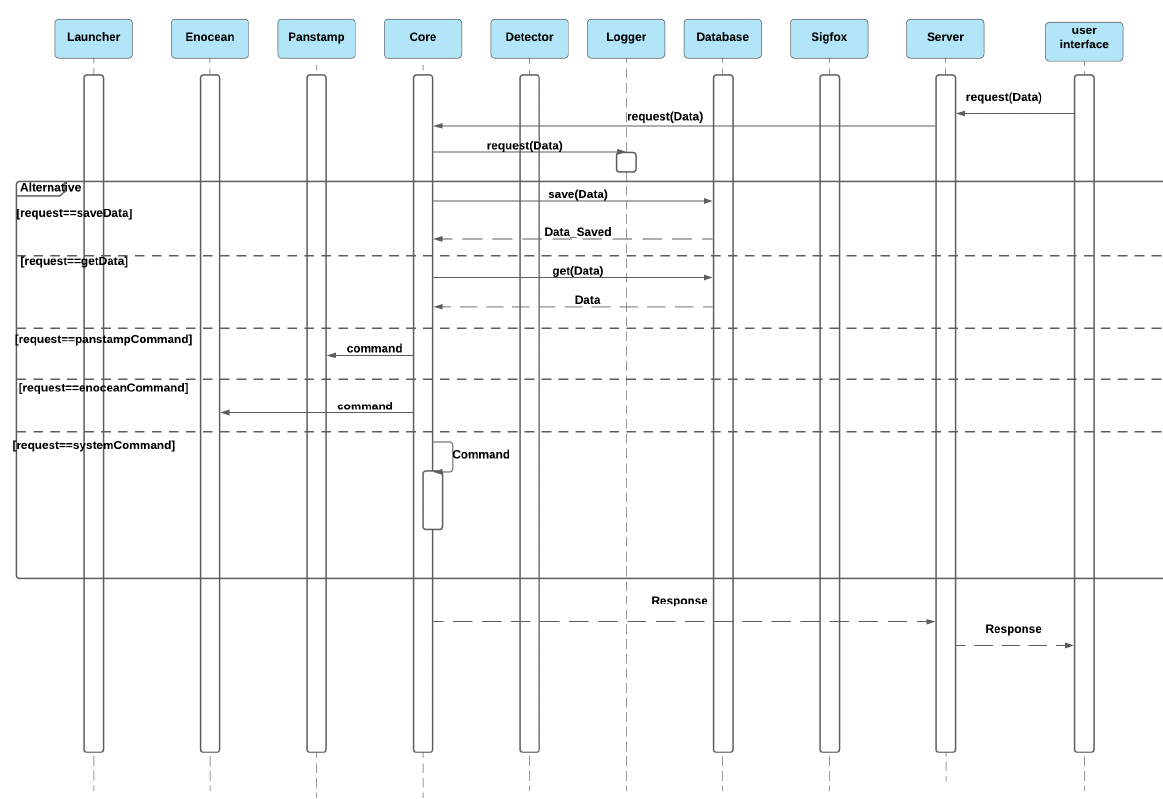
Figure 23. Receipt of occupant’s request sequence diagram.